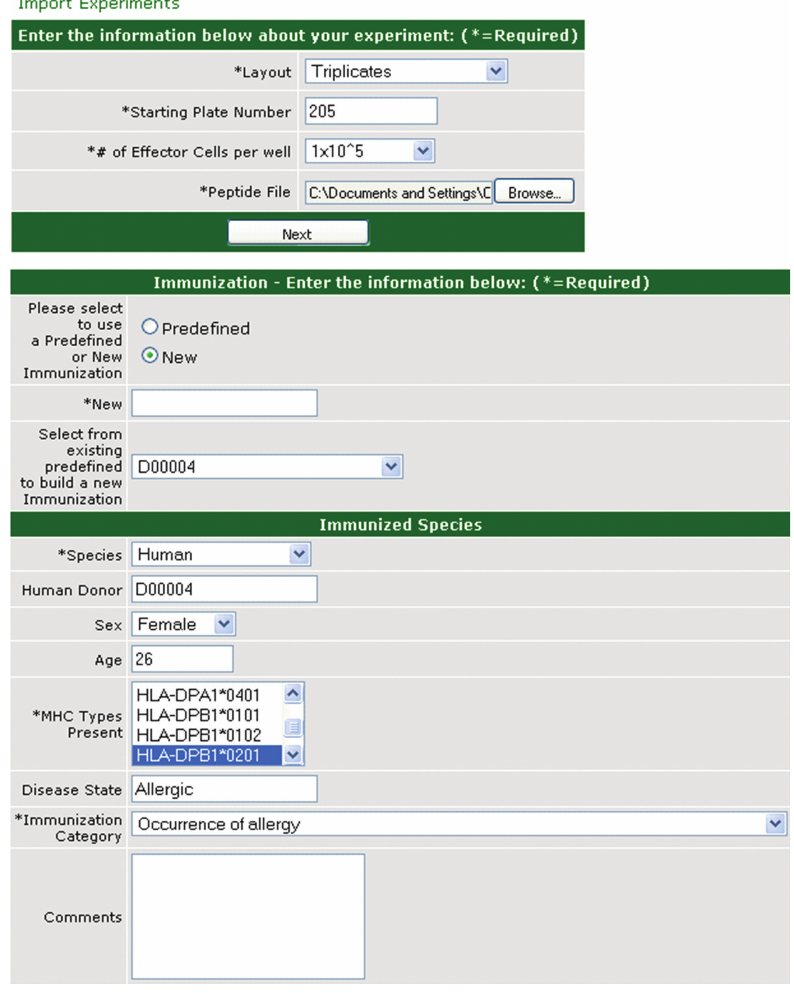
Figure 5: ELICAT database: experimental design functionality. The figure shows two screens used to capture the experimental design of an ELISPOT experiment. By specifying the donor from whom T cells used in the experiment were derived, the experiment becomes linked to the information for that donor in DONORDB, and some fields such as the HLA alleles expressed by that donor become prepopulated. ELICAT also allows the users to specify the type of cytokines and cells used in the experiments (not shown